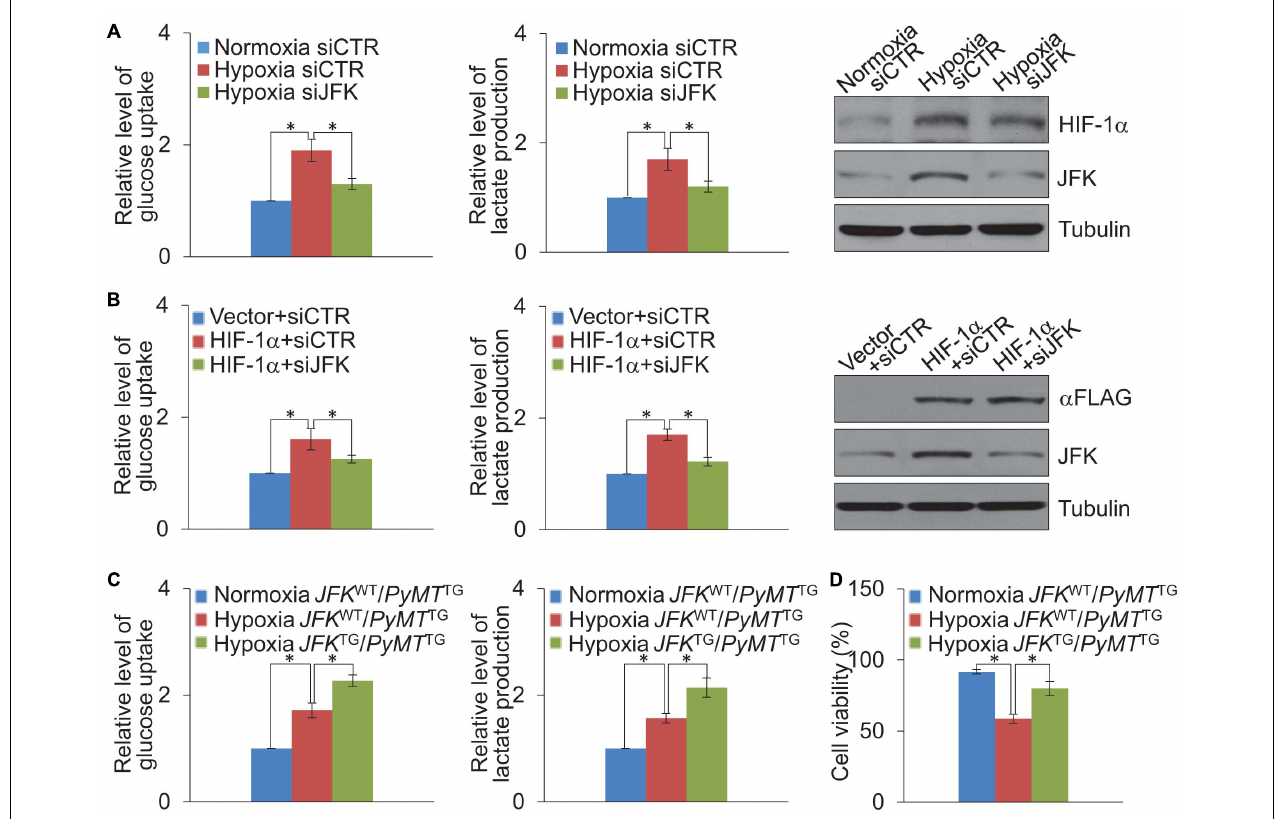
FIGURE 4 | JFK promotes HIF-1 α -induced glycolysis. (A) Cellular extracts or cell culture medium of MCF-7 cells treated with control or JFK siRNAs and cultured in hypoxia (1% O 2 ) conditions for 24 h were prepared for measurement of intracellular glucose or extracellular lactate. Error bars represent the mean ± SD for triplicate experiments. Cellular extracts were prepared for western blotting analysis with the indicated antibodies. (B) Cellular extracts or cell culture medium of MCF-7 cells treated with control or JFK siRNAs and transfected with vector or HIF-1 α were prepared for measurement of intracellular glucose or extracellular lactate. Error bars represent the mean ± SD for triplicate experiments. Cellular extracts were prepared for western blotting analysis with the indicated antibodies. (C) Cellular extracts or cell culture medium of primary tumor cells from JFK WT / PyMT TG or JFK TG / PyMT TG mice cultured in normoxia or hypoxia (1% O 2 ) conditions for 24 h were prepared for measurement of intracellular glucose or extracellular lactate. Error bars represent the mean ± SD for triplicate experiments. (D) Primary tumor cells from JFK WT / PyMT TG or JFK TG / PyMT TG mice cultured in normoxia or hypoxia (0.2% O 2 ) conditions for 72 h, followed by cell viability assessment. Error bars represent the mean ± SD for three independent experiments. Statistical significance of differences is indicated as * p <